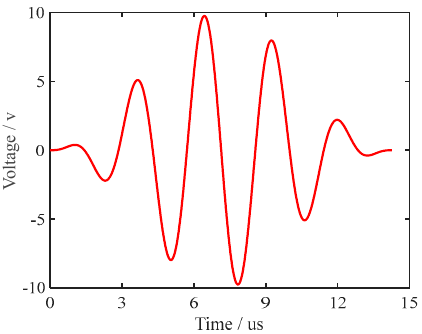
Figure 17. Excitation signal waveform with centre frequency of 350 kHz.